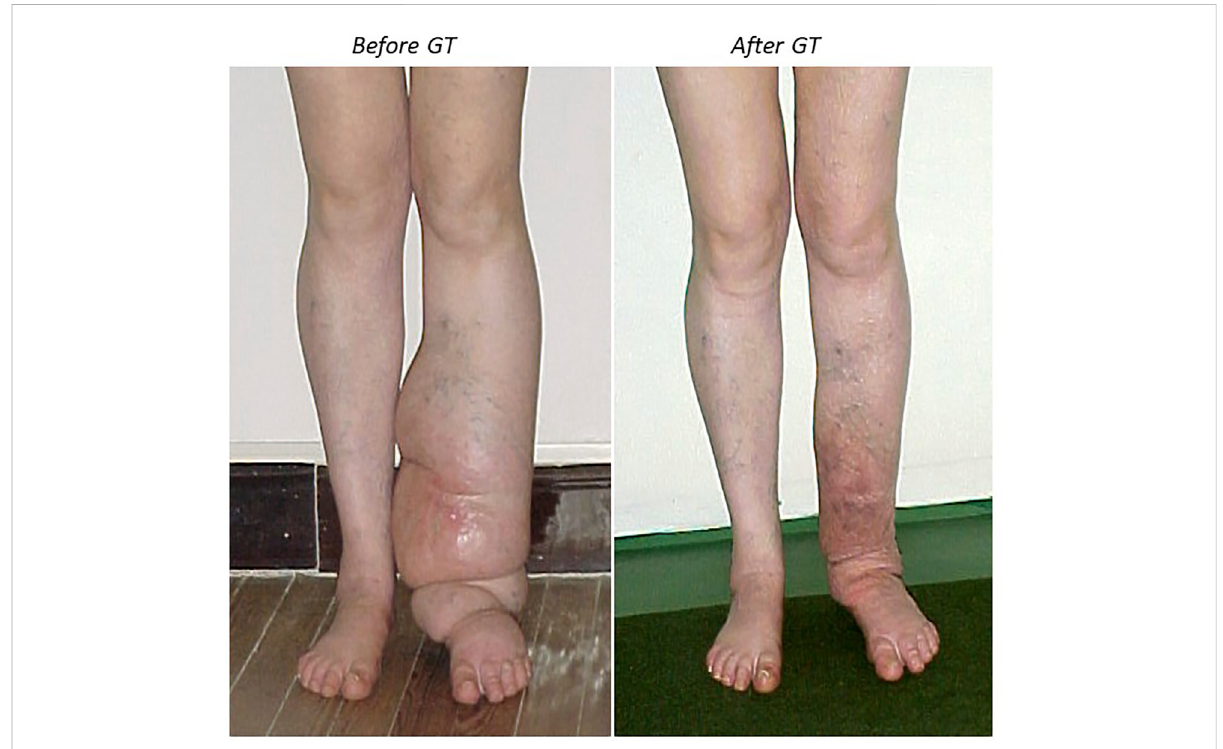
FIGURE 3 A lymphedema patient with gravitational therapy. A 48-year-old female patient with a severe lymphedema affecting left lower limb after 13 years of numerous erysipelas episodes (left). After 5 weeks of initiating gravitational therapy (10 sessions) there was a signi fi cant reduced edema (right). She could wear trousers and could sleep without the limb elevated. The leg perimeter had reduced from 70 to 29 cm, the quality of the skin improved and she did not repeat